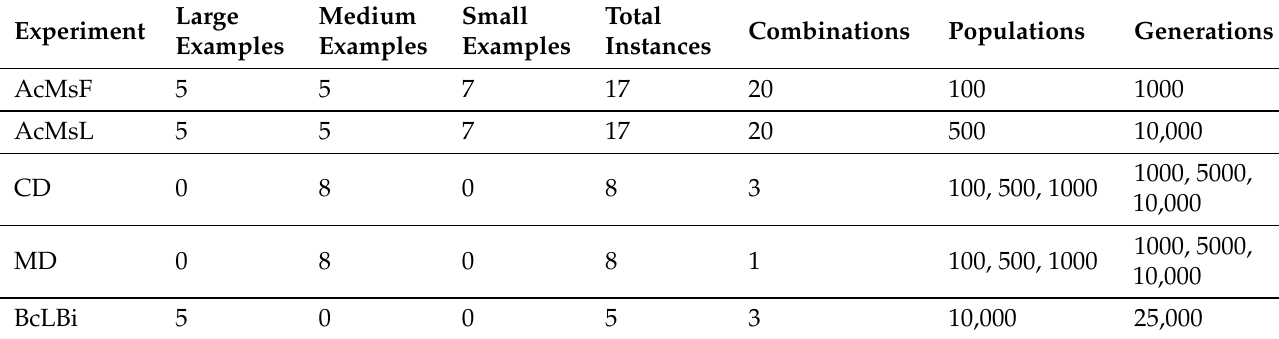
Table 1. Experiments for the genetic algorithm in the vehicle routing